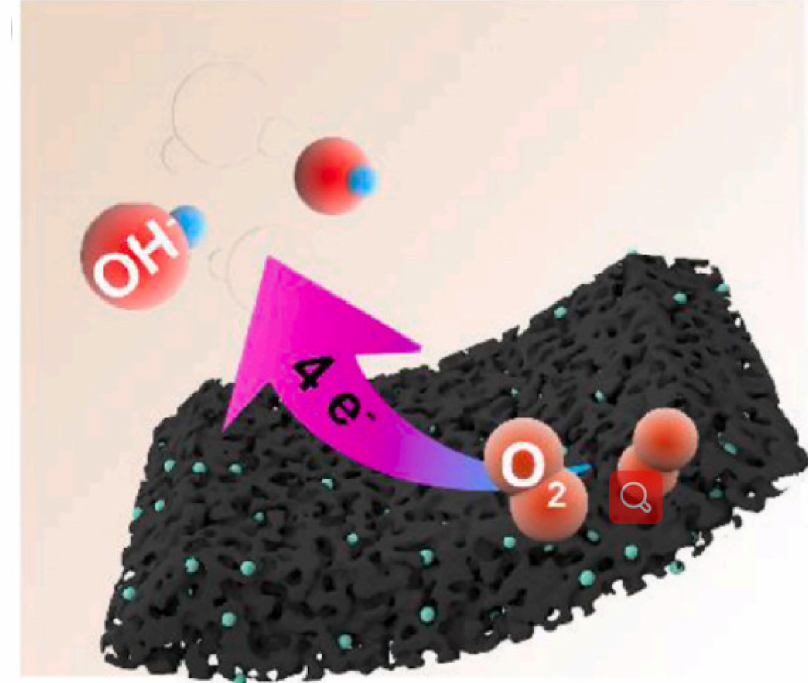
Figure 13. Mechanisms of CDs/NSPC for ORR [137].